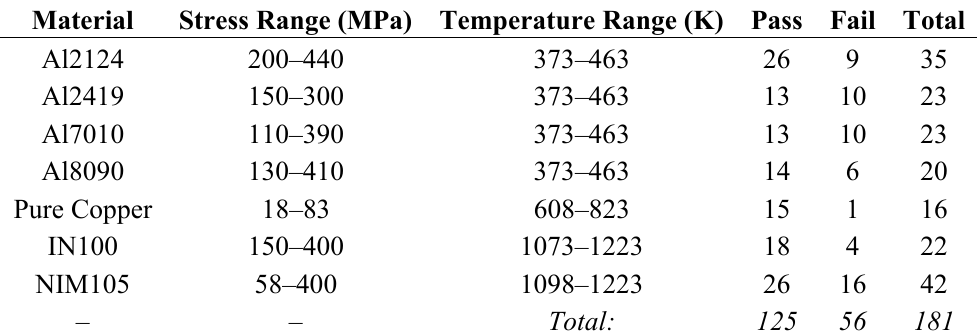
Table 3. Pass/Fail assessment of seven materials and 181 creep